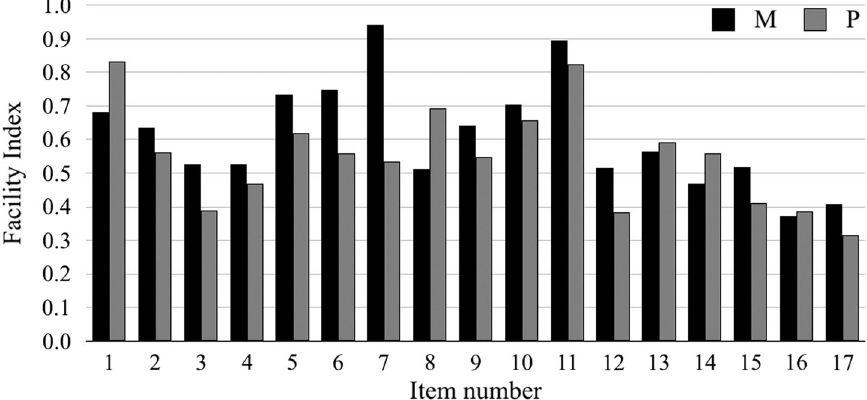
FIG. 3. Facility index vs item number in the two contexts of mathematics (labeled M) and of physics (labeled P).